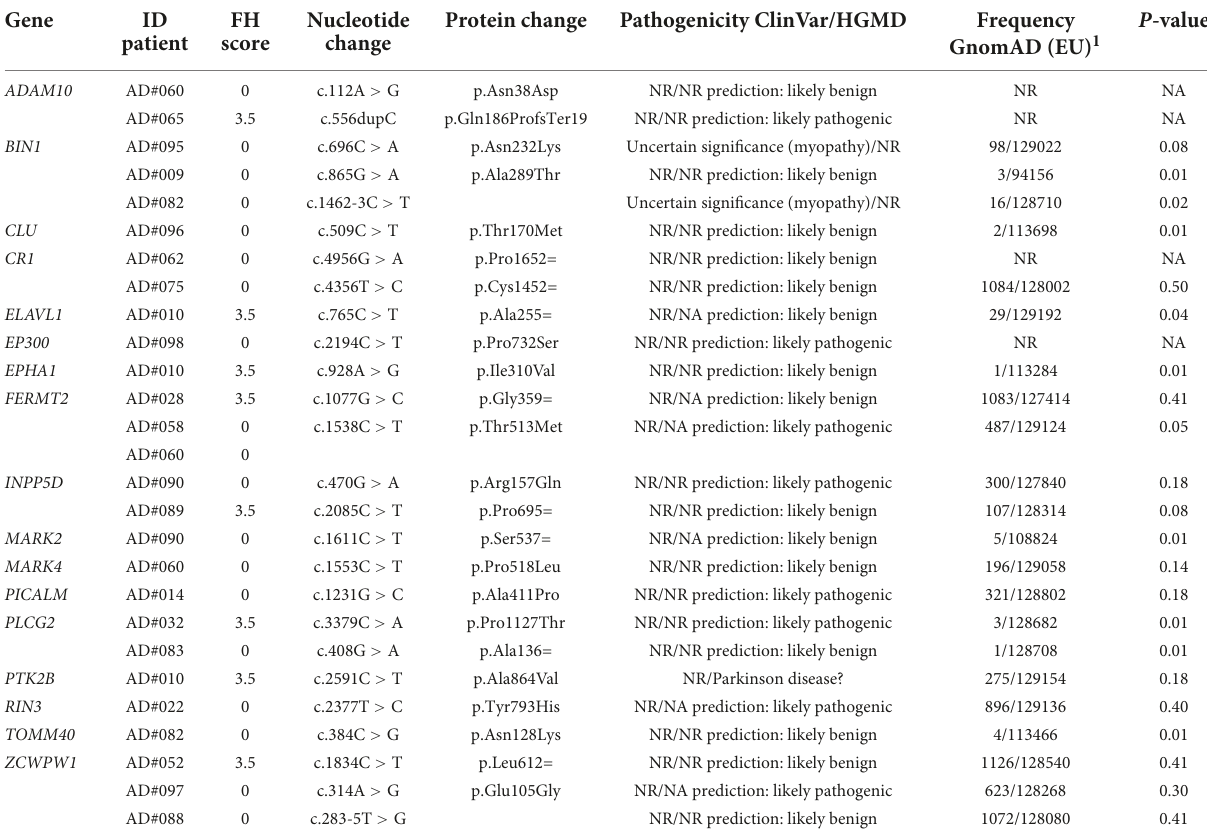
TABLE 6 Rare variants in GWAS genes identified in this